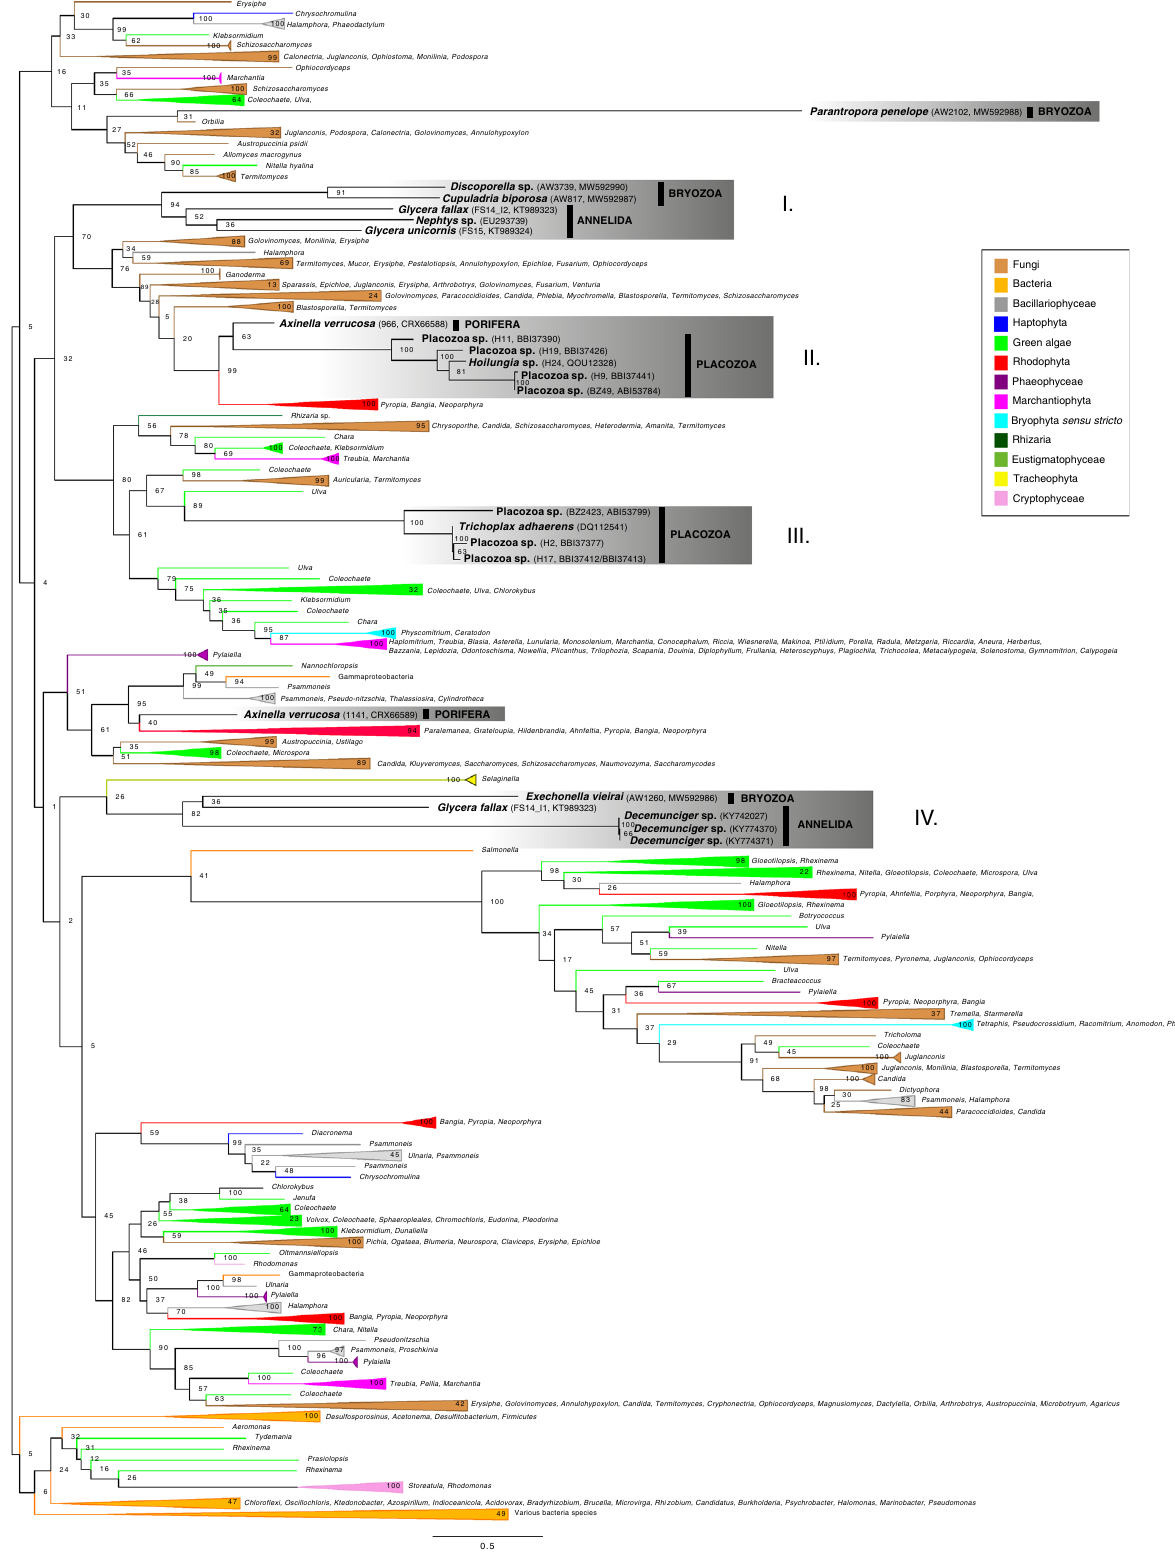
Figure 5. Maximum likelihood analysis of concatenated Group II reverse transcriptase and intron maturase open reading frames of Exechonella vieirai , Parantropora penelope, Discoporella cookae and Cupuladria biporosa and other metazoans (Porifera, Polychaeta, Placozoa), all emboldened and highlighted by shaded boxes, together with data from across the tree of life. Higher taxonomic affinities are colour coded (see insert). Ambiguously aligned positions had been excluded using Gblocks v.91b. Analysis was done using RAxML v.8.2.12 under the LG + G4 + F model with fast bootstrap analysis (1000 replicates). Values at nodes indicate maximum likelihood bootstrap values. Branch length scale bar indicates number of substitutions per site. Clades I–IV , as referred to in the text, are